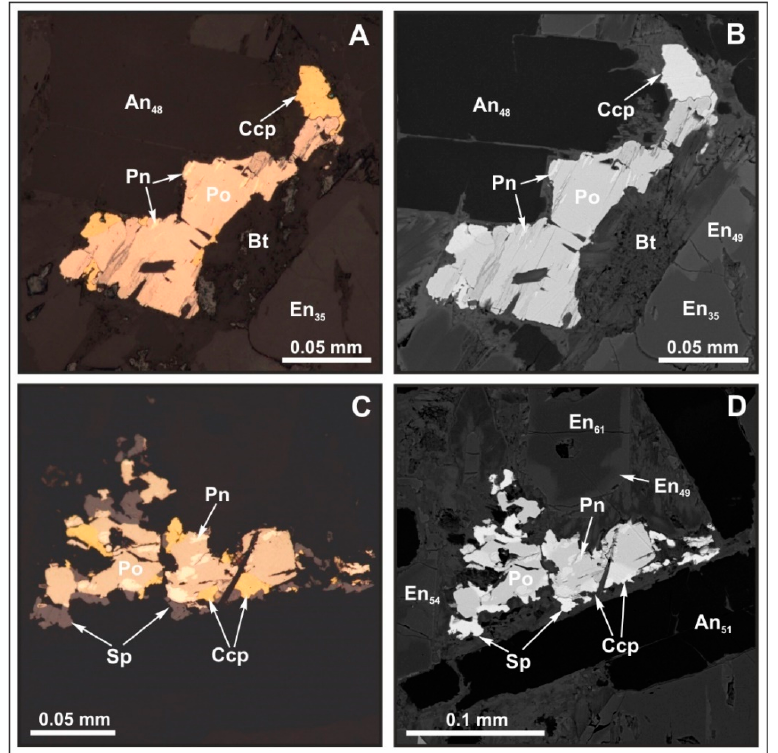
Figure 9. Typical intergrowths of multiphase Fe-Cu-Ni-Zn sulfides from the Kochumdek gabbro (sample PK-7-1). ( A , C ) = optical images in polarized reflected light; ( B , D ) = backscattered electron images (BSE). An = anorthite, Bt = biotite, Ccp = chalcopyrite, En = enstatite, Pn = pentlandite, Po = pyrrhotite, Sp =